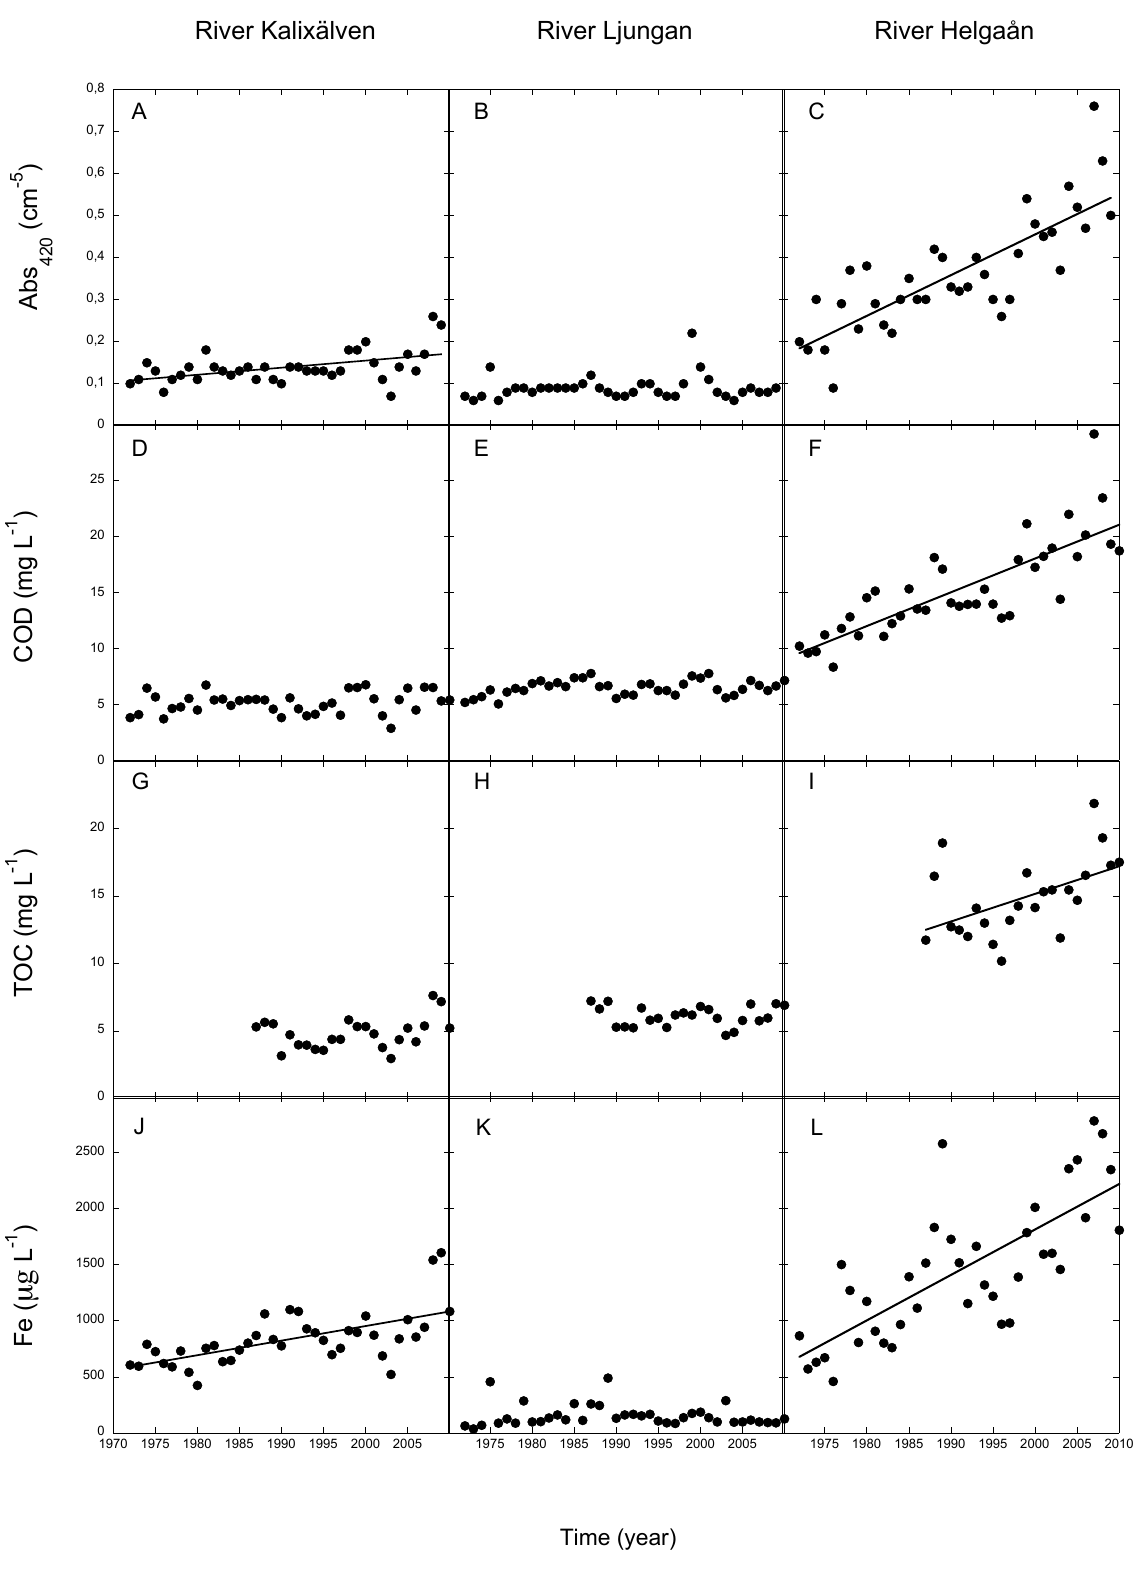
Fig. 3. Examples of trends in Abs 420 , COD, TOC and Fe in rivers in northern (Kalix˚an), central (Ljungan) and southern Sweden (Helga˚an). Trend lines are shown when there are significant increases over